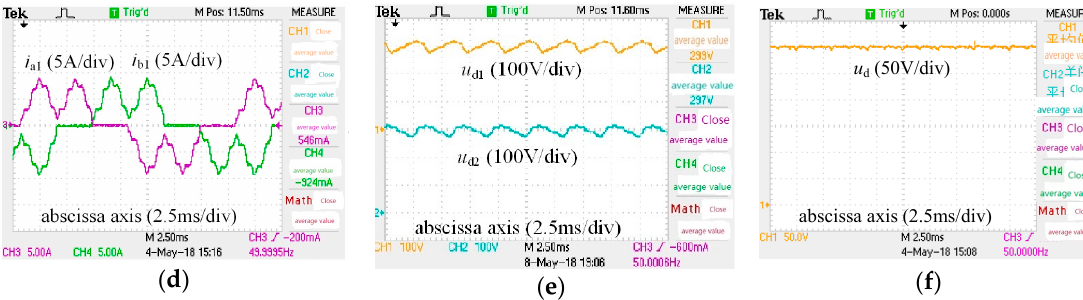
Figure 11. Measured waveforms of the proposed rectifier. ( a ) Currents i p and i q of diodes D p and D q . ( b ) Currents i m and i n of diodes D m and D n , and output current i f of SFR. ( c ) Output currents i d1 and i d2 of the two three-phase diode-bridge rectifier. ( d ) Input currents i a1 and i b1 of the three-phase diode-bridge rectifier I. ( e ) Output voltages u d1 and u d2 of the two three-phase diode-bridge rectifier. ( f )Load voltage.